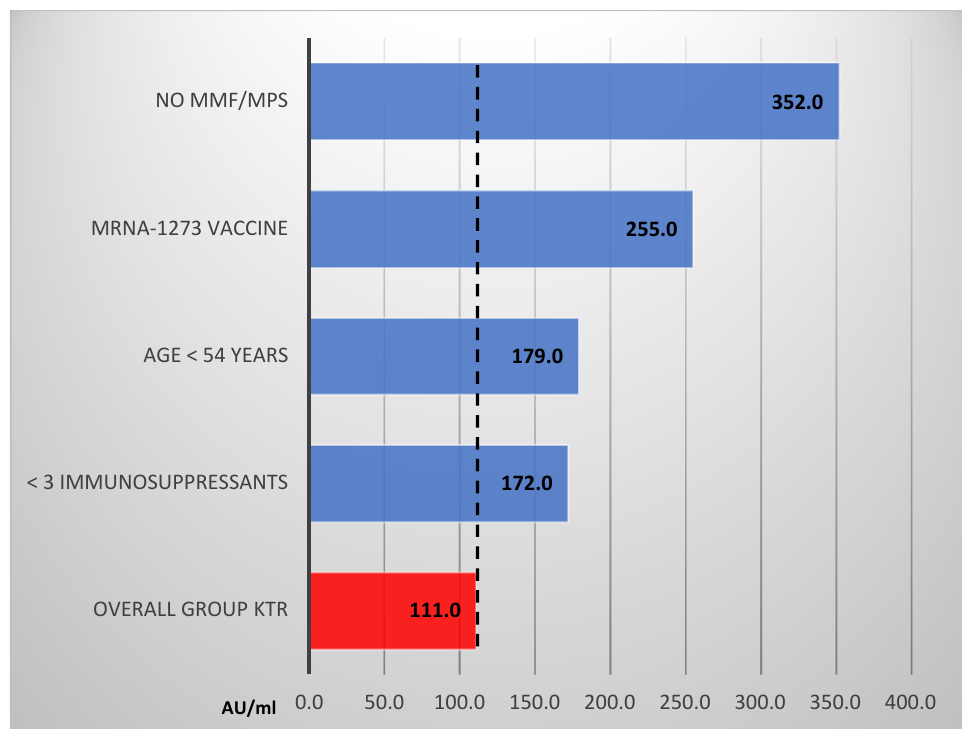
Figure 3. Strata analyses of anti-s IgG titer (AU/mL) in KTR responders. Legend: MMF/MPS; mycophenolate mofetil/Na.